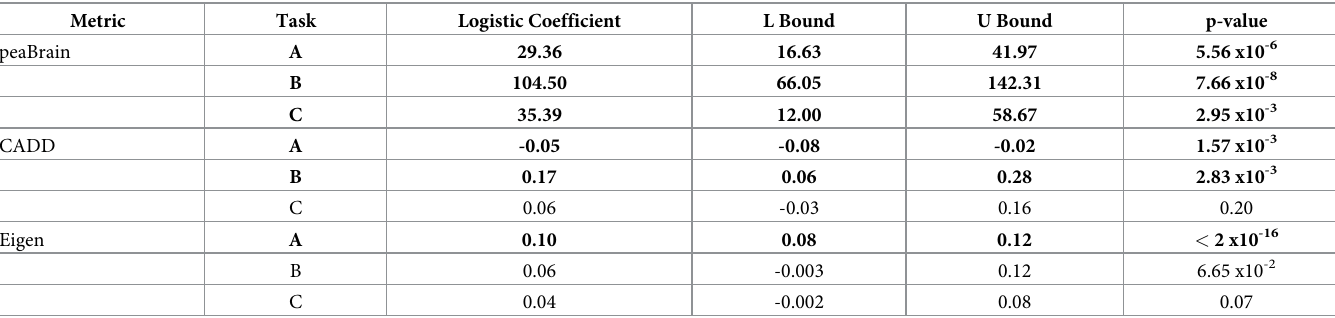
Table 1. Tabulated statistics (to two decimal places) from the logistic models for the three non-coding metrics from tasks A-C. Metric